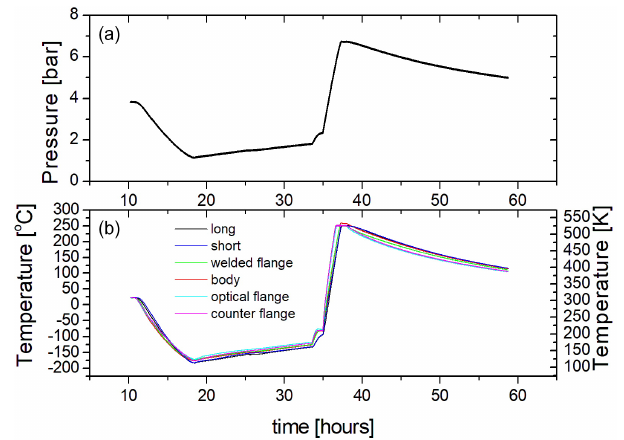
Figure 7. The difference of the temperature obtained from the NIST tables for the pressure of the Ar gas with respect to the gas tem- perature measured by the “long” thermocouple (black curve). The agreement is ± 2K. The red curve corresponds to the gas tempera- ture obtained from the NIST